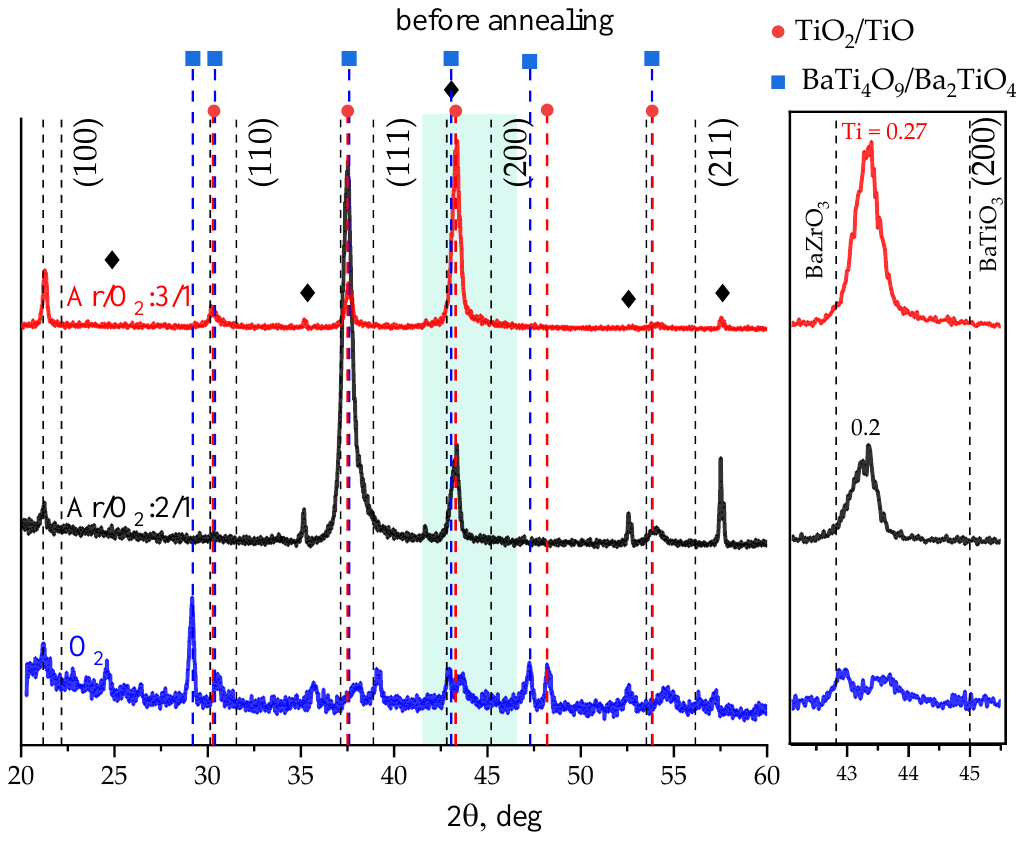
Figure 3. Diffractograms of BZT thin films on Al 2 O 3 substrates deposited at different oxygen concentrations in gas ambient at a substrate temperature of 800 °C.